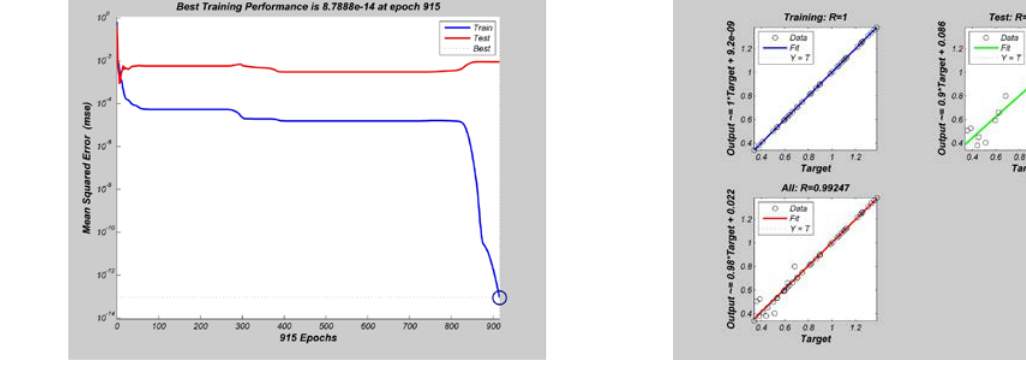
Fig. 3. Mean Square Error-Number of Epochs Fig. 4 Correlation Coefficient